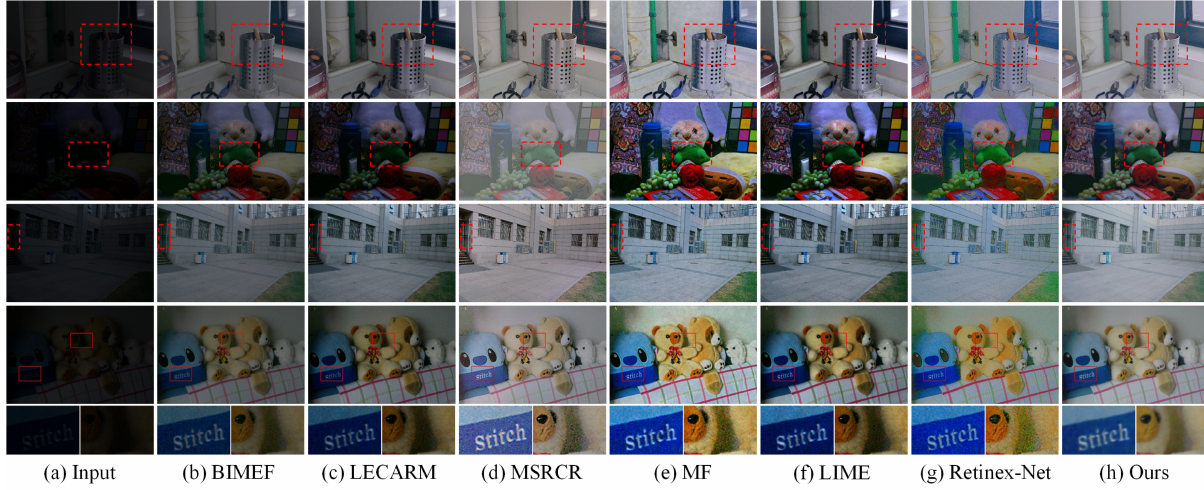
Figure 6. Visual comparison of the proposed method and the state-of-the-art methods on images from LOL dataset but outside our training